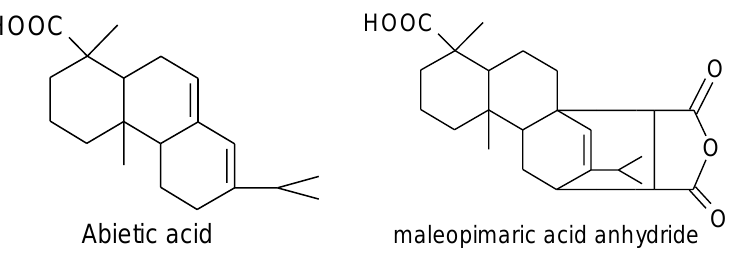
Scheme 1. Structure formula of abietic acid and maleopimaric acid anhydride.